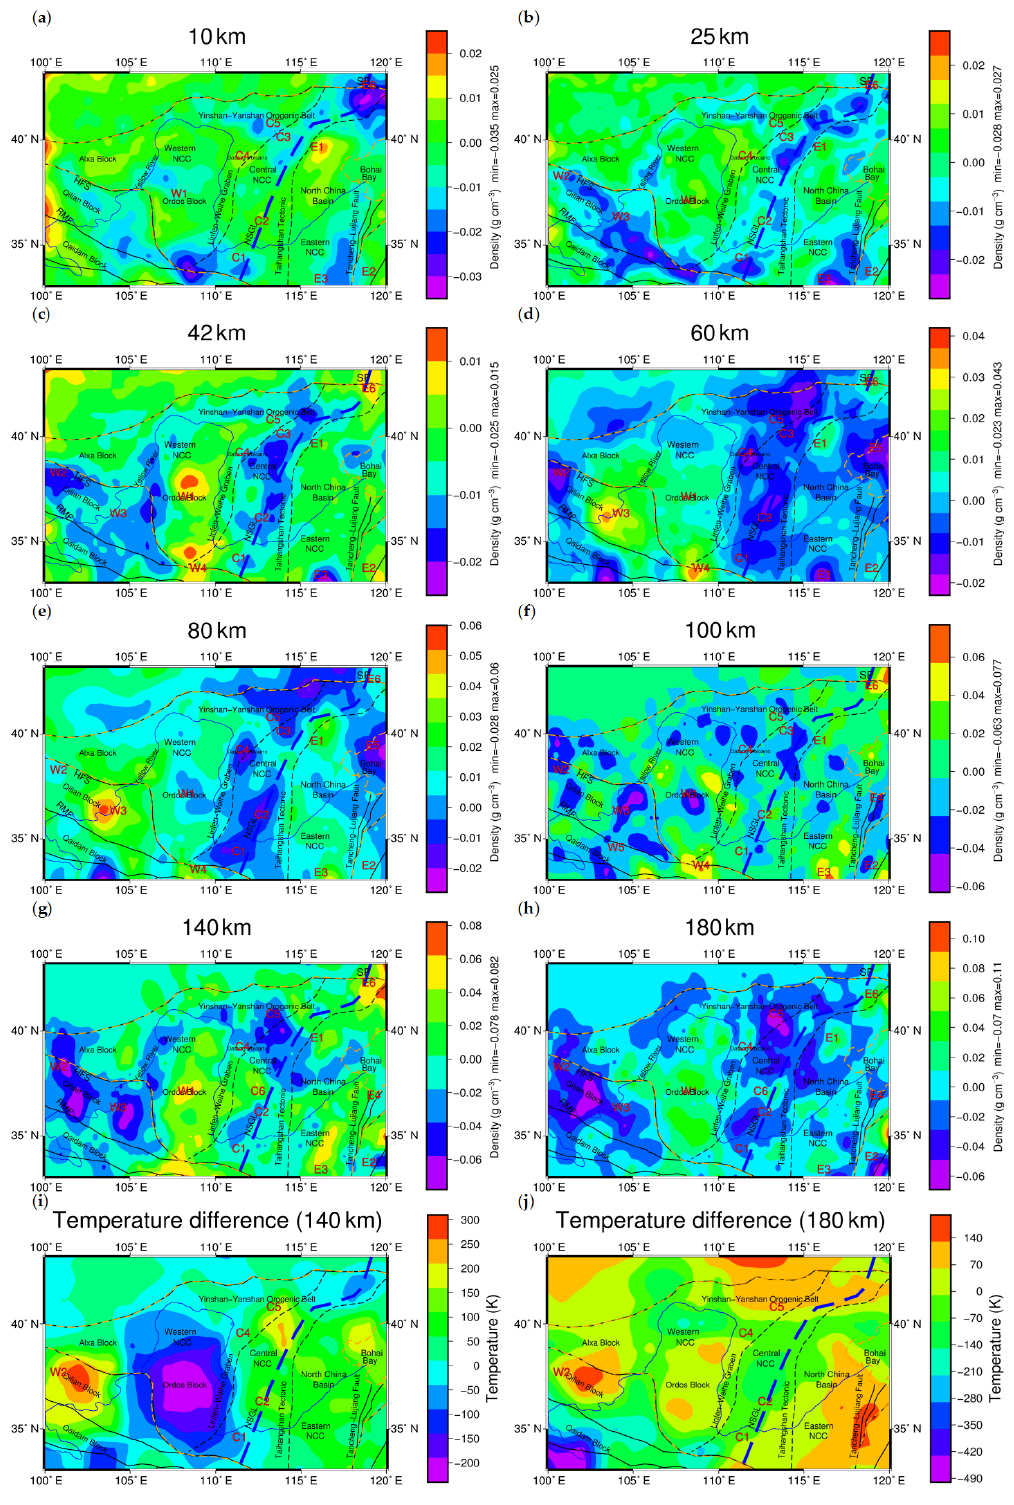
Figure 15. Lithospheric density distribution in the NCC at different depths: (a) 10km, (b) 25km, (c) 42km, (d) 60km, (e) 80km, (f) 100km, (g) 140km and (h) 180km. Temperature differences at (i) 140km and (j) 180km. E represents the eastern NCC, C represents the central NCC and W represents the western NCC; HFS is the Haiyuan fault system, RMF is the Riyue mountain fault and SP is the Songliao